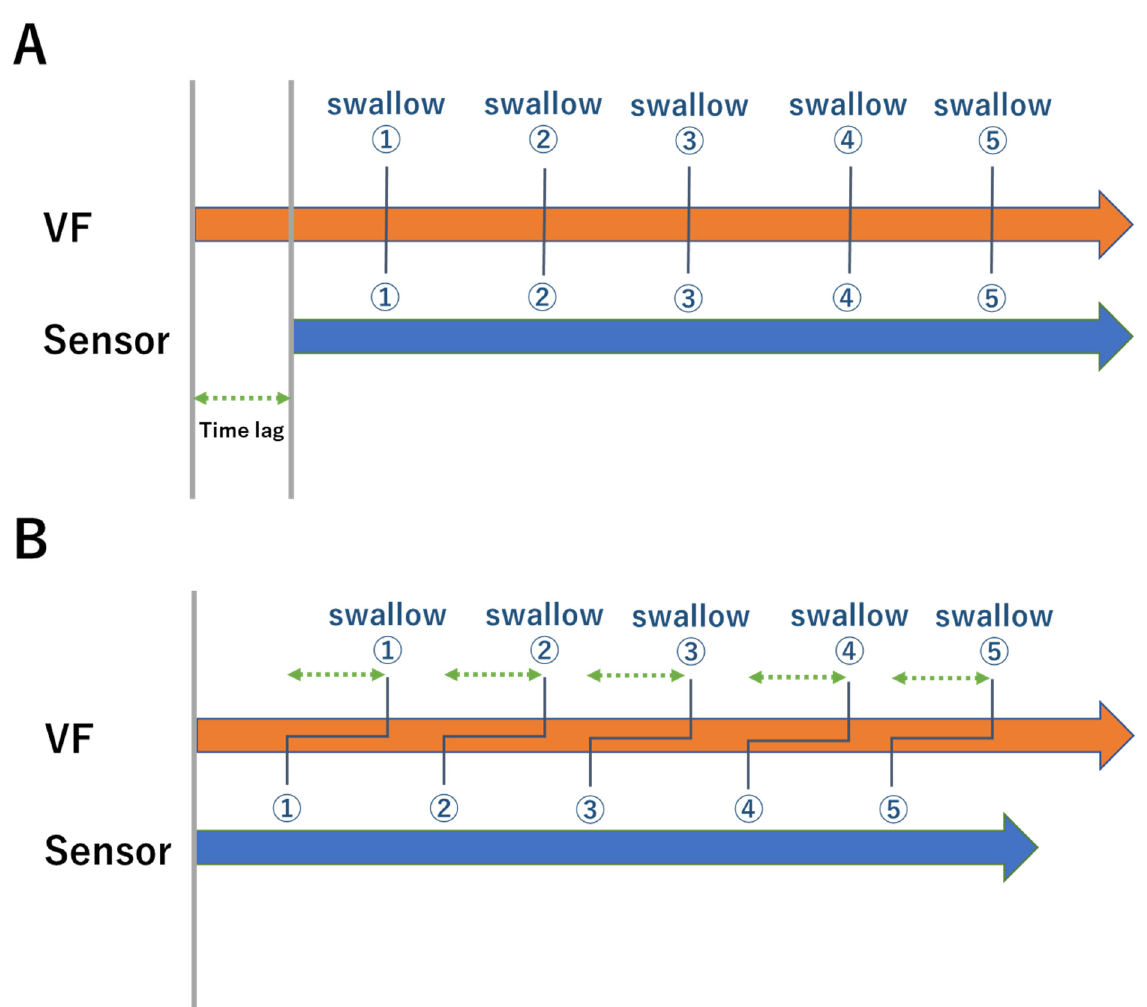
Figure 3. Data correction method. ( A ) Data from five swallowing trials were continuously recorded. As the start time of recording was different between the VF and the sensor, there a time lag in the data was recorded. ( B ) The time lag was determined on the basis of the audio recorded at the same time, and the corrected time of emergence of SA to SC was used for the analysis. Numbers in the figure show the number of swallowing trials. VF: Videofluoroscopy; SA: Time the waveform was at its lowest point; SC: Time the waveform decreased.